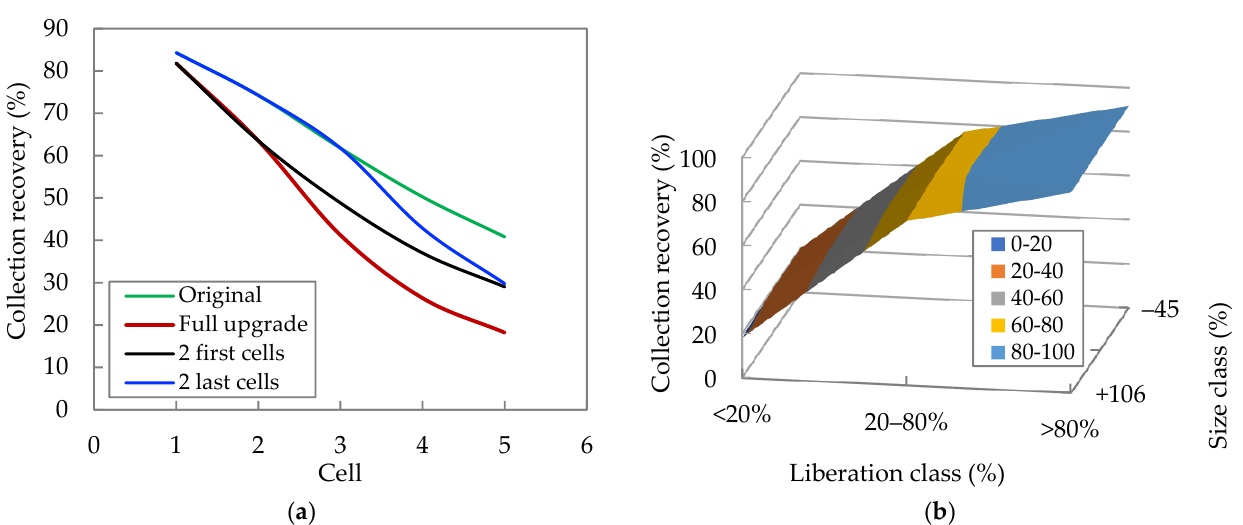
Figure 9. ( a ) Collection recovery along the bank for the four scenarios and ( b ) collection recovery per particle size and liberation class (first cell, original circuit).